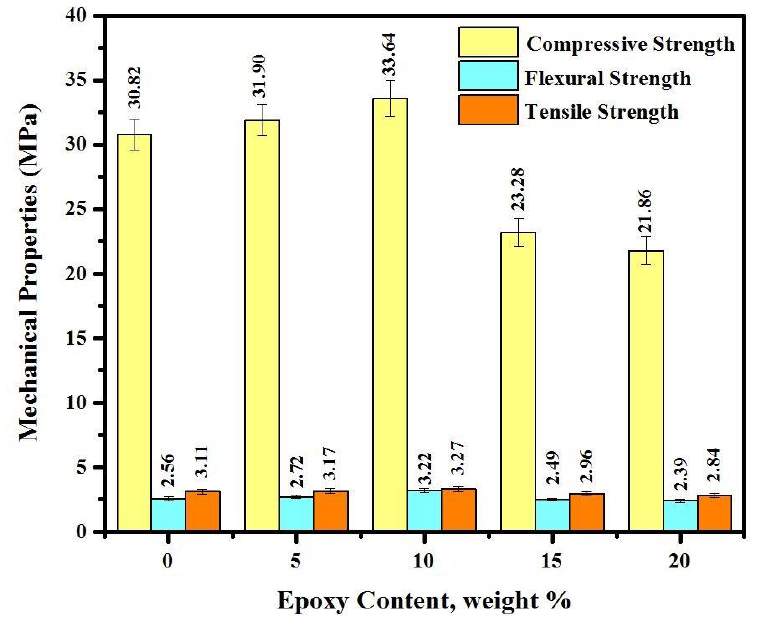
Figure 6. Mechanical properties of all tested specimens.